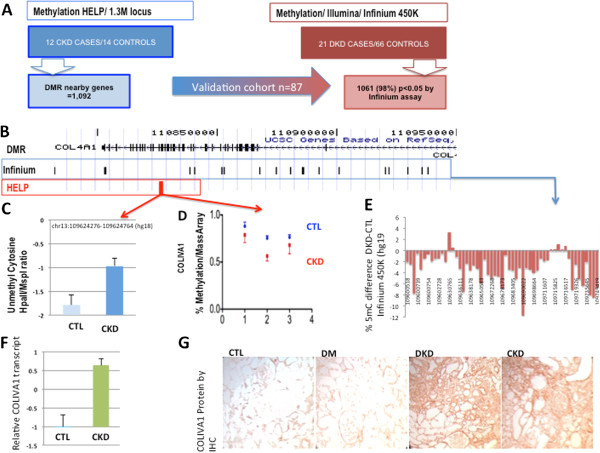
External and internal validation of the observed changes. (A) Correlation of the DMRs identified in 26 samples using the HELP method and an external dataset containing 87 human kidney samples analyzed using Illumina Infinium 450K arrays. We found concordant regulation of 1,061 transcripts (98%) from the 1,092 mapped genes using this validation dataset. Of transcripts that showed both differential methylation and expression, 404 (97%) were confirmed. (B) An example of a DMR identified by the HELP assay and confirmed in the validation dataset. This DMR is localized in the intronic region of COLIVA1. (C) Methylation status and (D) gene expression of COLIVA1 in the original HELP dataset in control and CKD samples. (E) MassArray confirmation of methylation status of the COLIVA1 locus (blue is mean ± standard deviation of control samples, red is mean ± standard deviation of CKD samples). (F) Methylation status of the COLIVA1 locus in the validation dataset (Infinium 450K arrays). The data represent the mean differences in absolute methylation levels of individual cytosines at the COLIVA1 locus. (G) Immunohistochemistry of COLIVA1 expression in control (CTL), diabetic (DM), DKD and CKD kidneys.